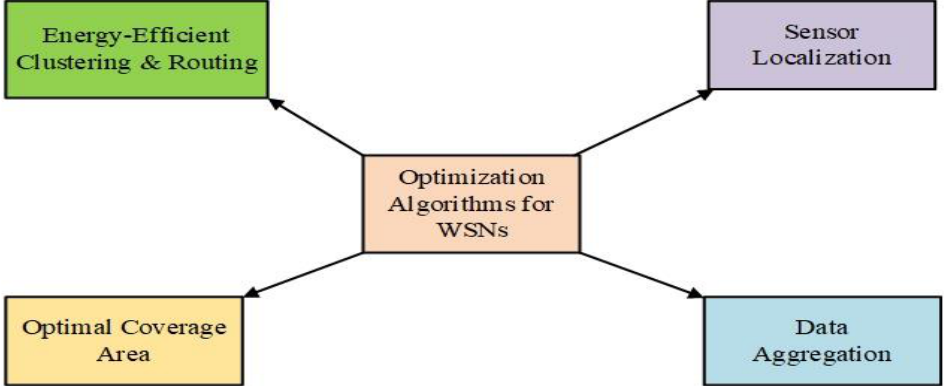
Figure 3. Problem domains found in the active research area of Wireless Sensor Network.